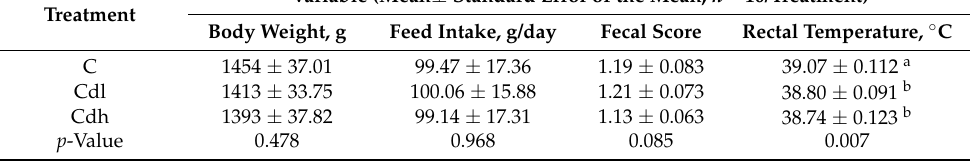
Table 4. Body weight, feed intake, fecal score, and rectal temperature of rabbits treated with different concentrations of Cleome droserifolia (Forssk.) Del. (Cd) (0: C, Cdl: 1.25 g/kg of DM diet, or Cdh: 2.5 g/kg of DM diet). Treatment